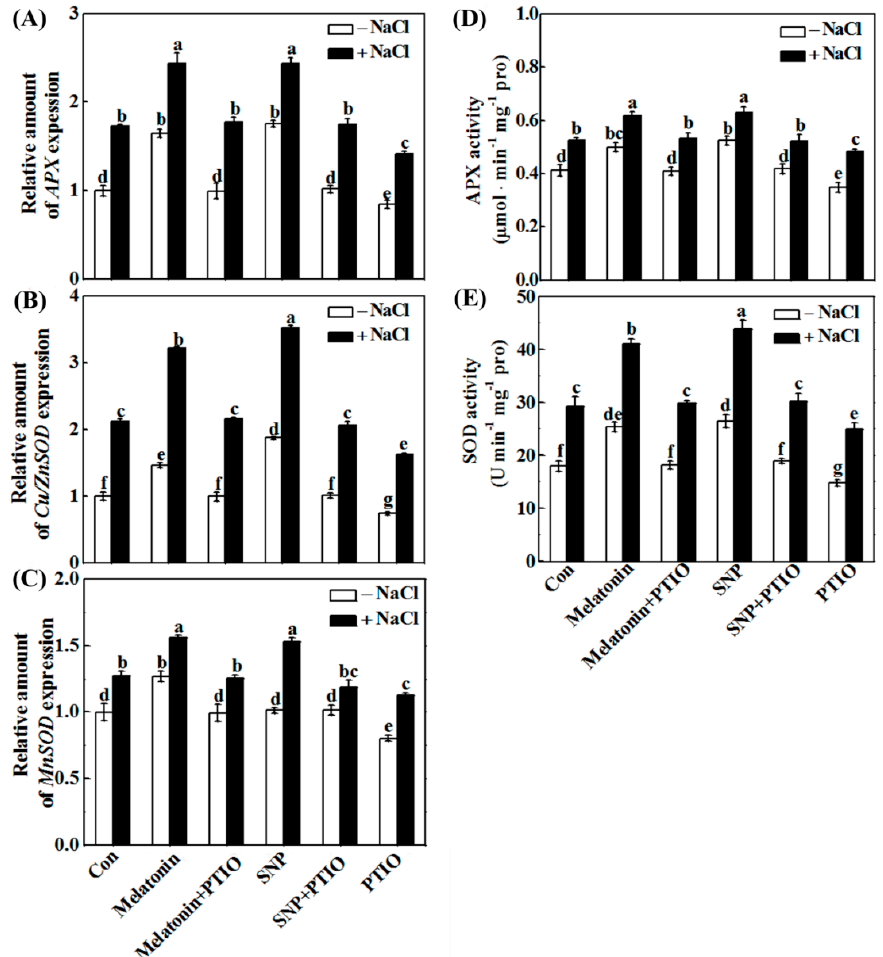
Figure 7. Antioxidant genes and corresponding enzymatic activities were modulated by melatonin-mediated NO. Three-day-old rapeseed seedlings were pretreated with 1 μ M melatonin, 10 μ M SNP, 200 μ M PTIO, alone or their combinations for 12 h, and then transferred to 200 mM NaCl for another 12 h ( A – C ) or 2 days ( D , E ). Then, the mRNA expression of APX ( A ), Cu/ZnSOD ( B ), and MnSOD ( C ) in root tissues was analyzed by qPCR. The activities of ascorbate peroxidase (APX; ( D )) and superoxide dismutase (SOD; ( E )) were determined. The sample without chemicals was the control (Con). Values are means ± SE of three independent experiments with at least three replicates for each. Bars with different letters are significant different at p < 0.05 according to Duncan’s multiple range test.